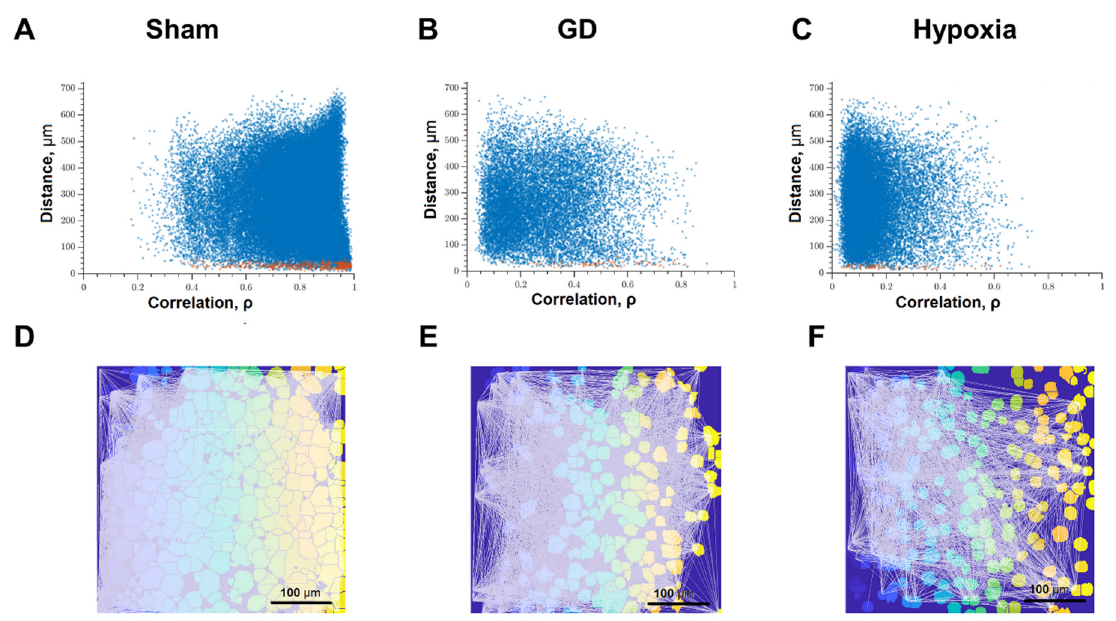
Figure 5. Correlation dependence between spontaneous Ca 2+ oscillations and cell distance (red dots—pairs of neighboring cells, blue dots—pairs of distant cells): ( A ) Intact; ( B ) glucose deprivation, ( C ) hypoxia; representative correlation network graphs with a threshold of >0.3. ( D ) Intact; ( E ) glucose deprivation; ( F ) hypoxia.